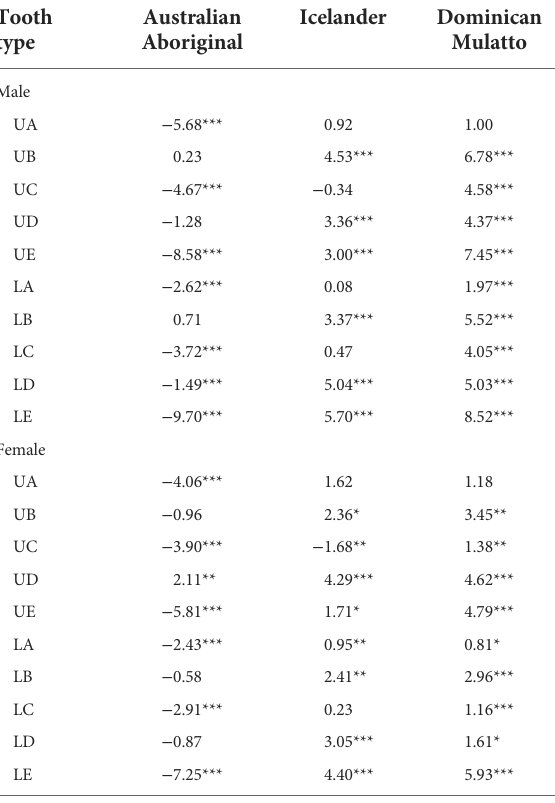
TABLE 11 Difference between the crown index of the primary teeth of northwest Chinese and those of the other populations. Tooth